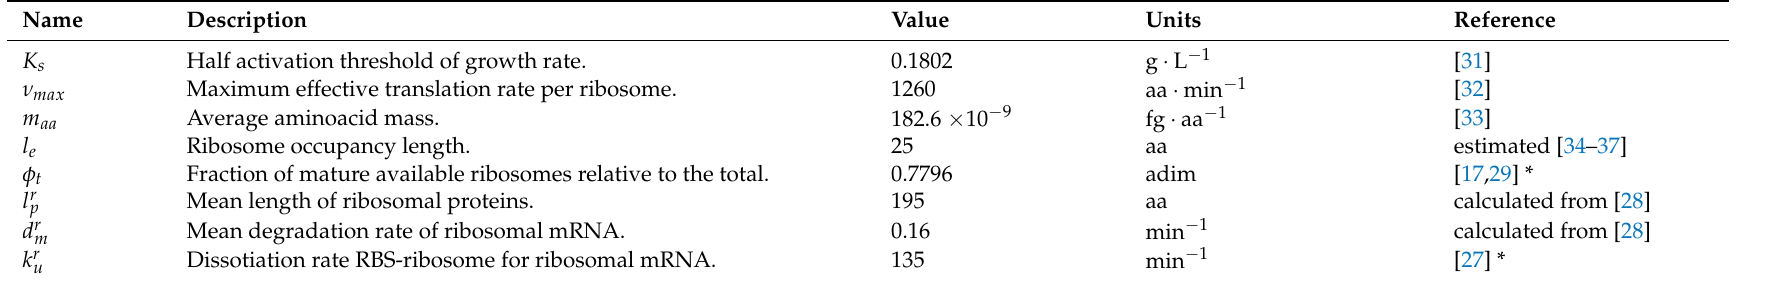
Table 3. Parameters of the